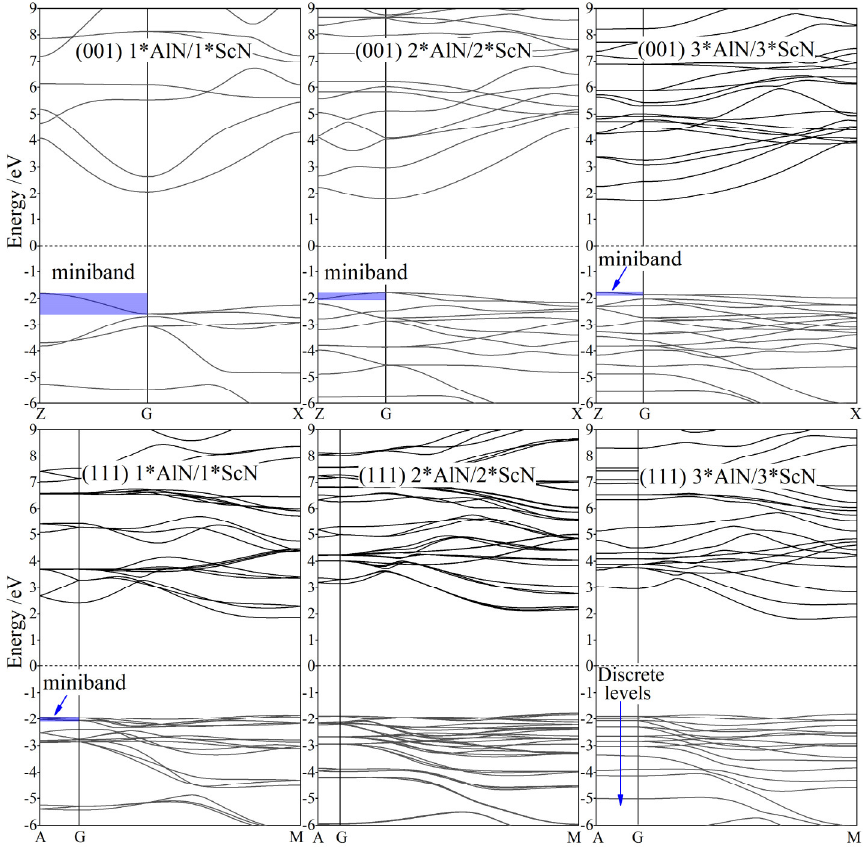
Figure 2. Band structures of the (001) and (111) n*AlN/n*ScN superlattices ( n = 1,2,3) in the dispersion paths through high symmetry points in the Brillouin zone as indicated in Figure 1; the Fermi level (horizontal dash line) is referenced as energy zero.